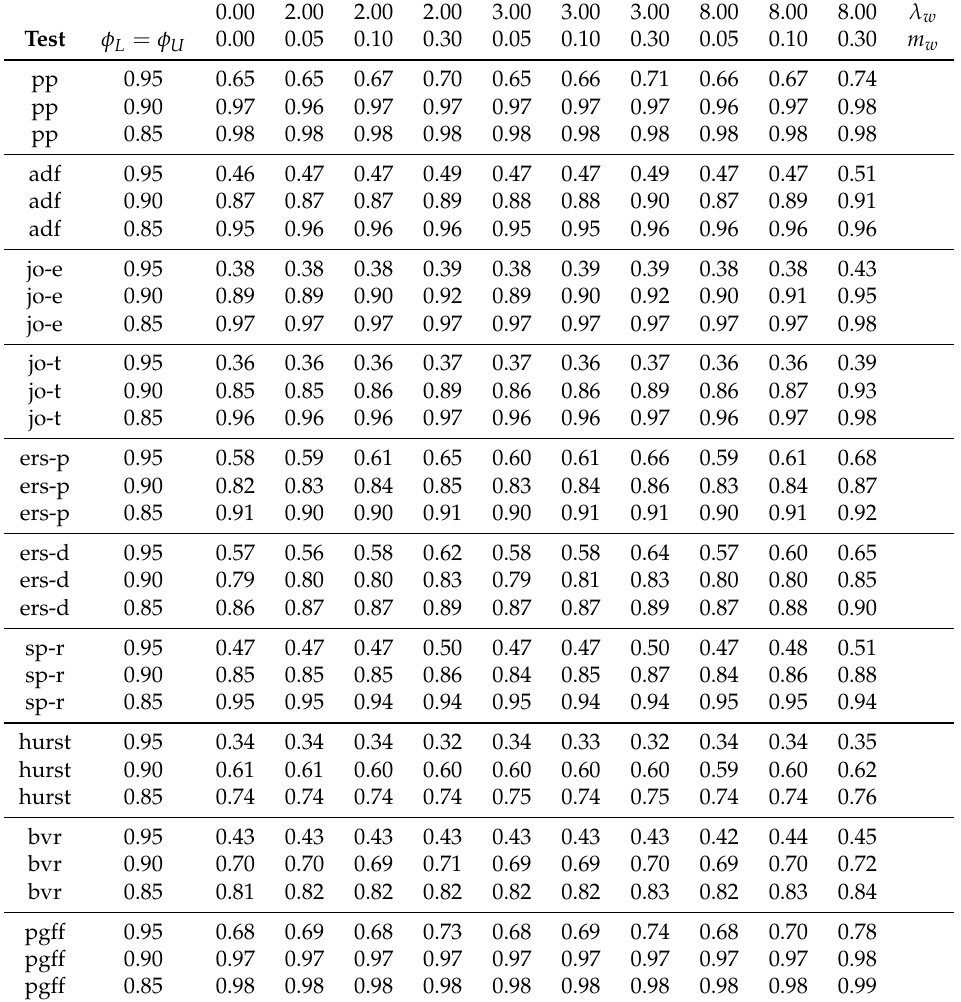
Table 13. Power of cointegration tests for Monte Carlo settings of Type V, as described in Subsection